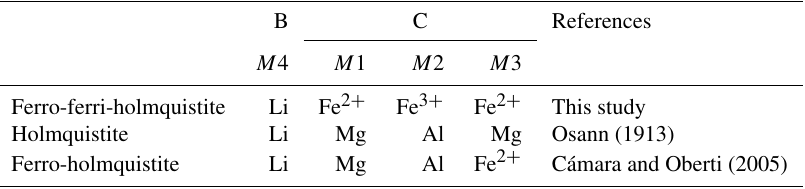
Table 9. List of orthorhombic lithium amphiboles ∗ .